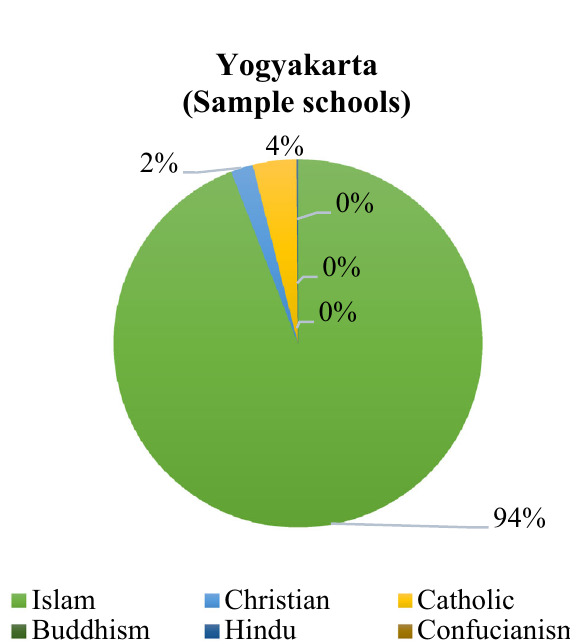
Fig. 4 Research population. Multireligious school samples in